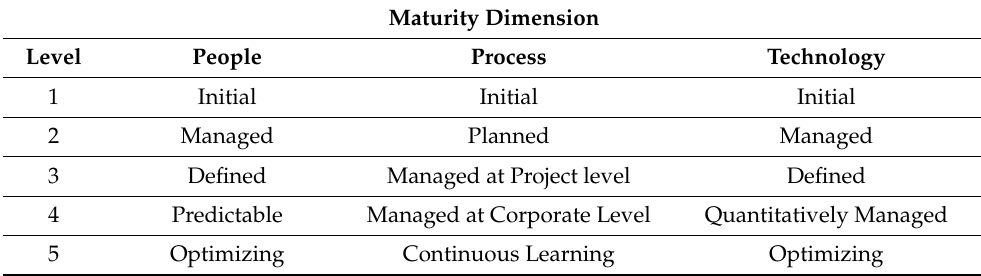
Table 1. Summary of the assessment of the three dimensions of people, process, and technology. Maturity